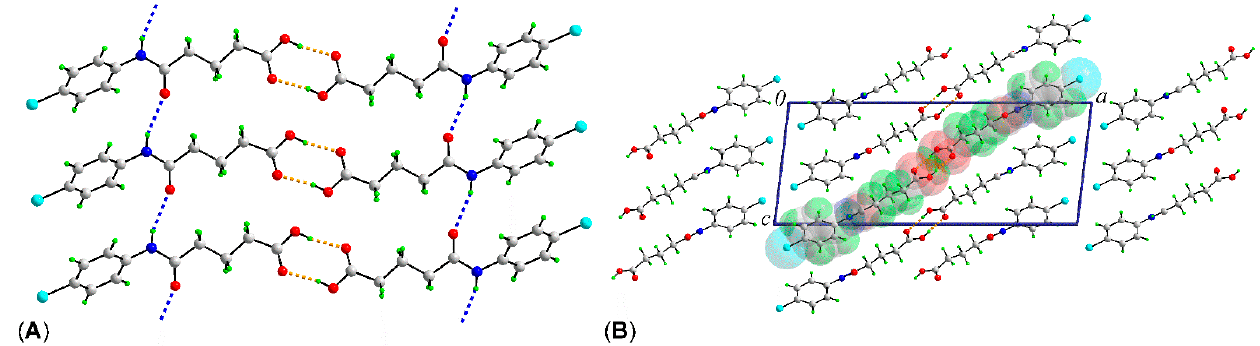
Figure 2. Molecular packing in the crystal of ( 1 ): ( A ) a view of the supramolecular tape featuring O–H ... O and N–H ... O hydrogen bonding, shown as orange and blue dashed lines, respectively, and ( B ) a view of the unit-cell contents shown in projection down the b -axis; one tape has been highlighted in space-filling mode. Selected intermolecular parameters: O2–H2o ... O1 i : [H2o ... O1 i = 1.84(4) Å, O2 ... O1 i = 2.651(4) Å and angle at H2o = 169(5)° for symmetry operation (i) 1- x , 1- y , 2- z ], N1–H1n ... O3 ii [H1n ... O3 ii = 2.208(19) Å, N1 ... O3 ii = 3.027(4) Å and angle at H1n = 159(3)° for (ii) x , 1+ y , z ].